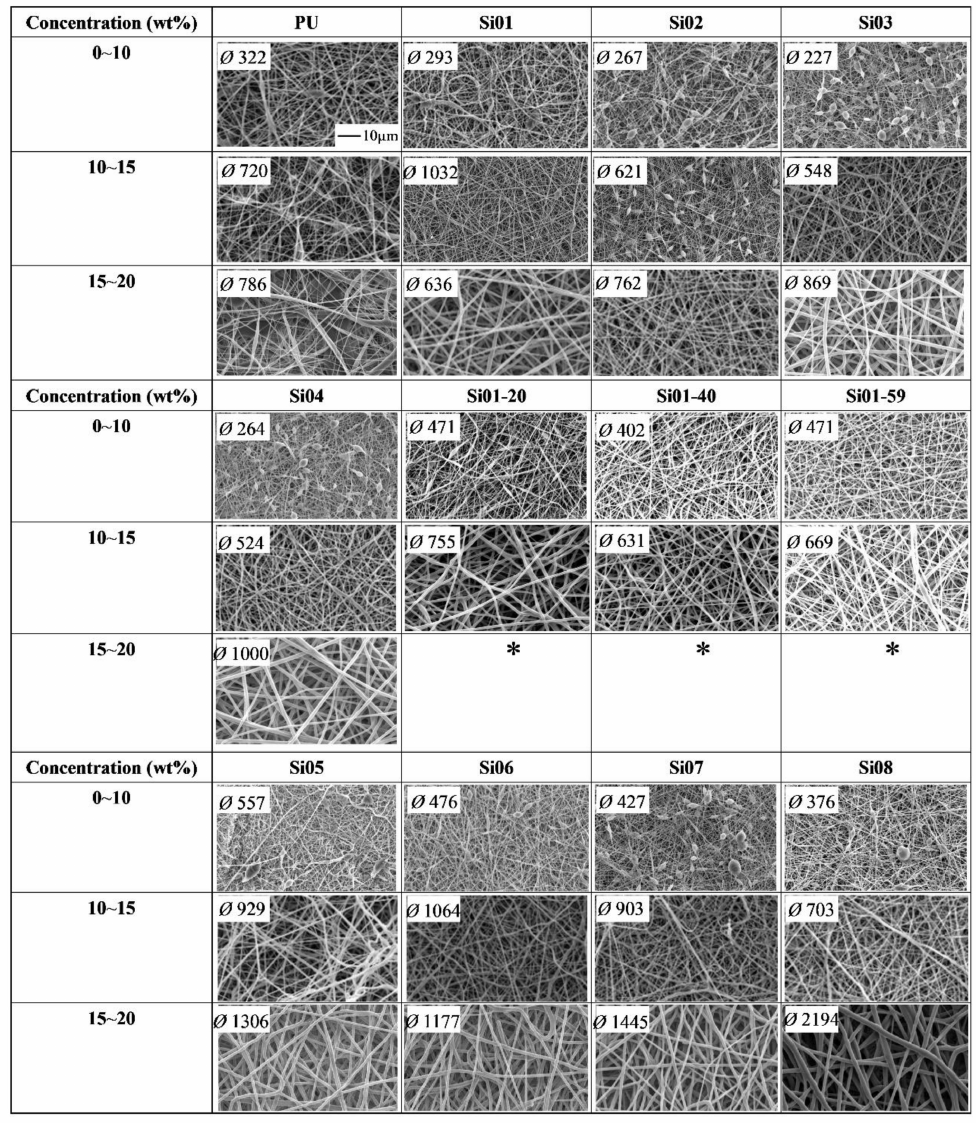
Table 2. SEM morphologies of the electrospun PUSX nanofibers with various structures and